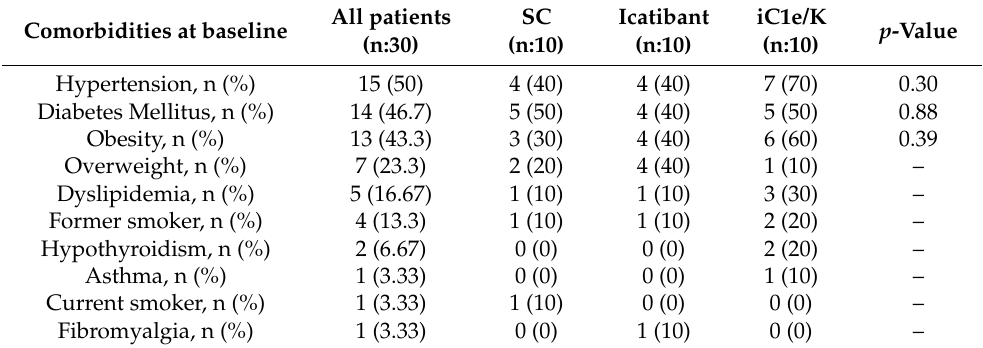
Table 2. Pre-morbid conditions of patients included in the study.